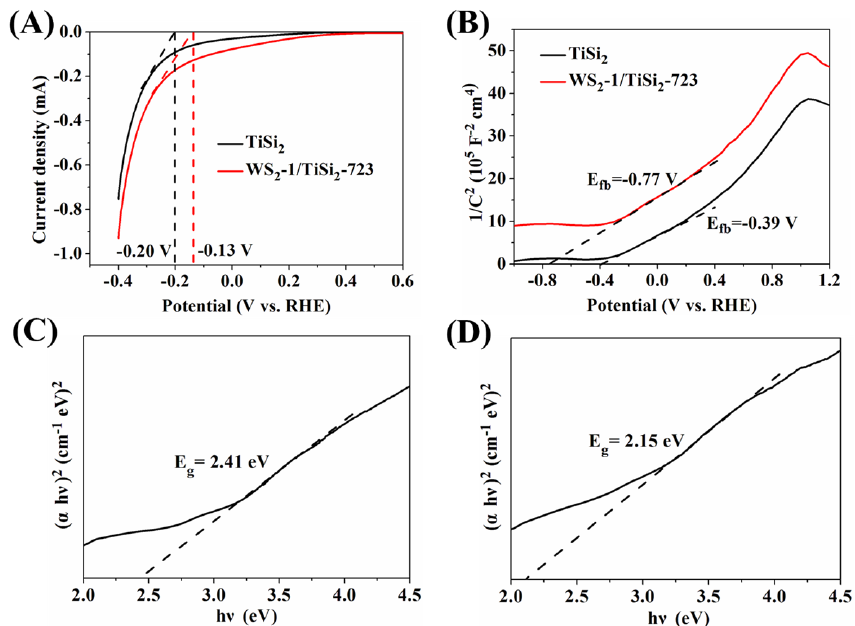
Figure 5. ( A ) The linear sweep voltammetry plots of the TiSi 2 and WS 2 -1/TiSi 2 -723 electrodes scanning from − 1.0 to 0 V vs. SCE (saturated calomel electrode) with a scan rate of 50 mV · s − 1 , the proton reduction potential at 0 mA is − 0.20 V for TiSi 2 and − 0.13 V for WS 2 -1/TiSi 2 -723; ( B ) the Mott-Schottky plots of the TiSi 2 and WS 2 -1/TiSi 2 -723 electrodes. Tauc plots of ( C ) TiSi 2 and ( D ) WS 2 -1/TiSi 2